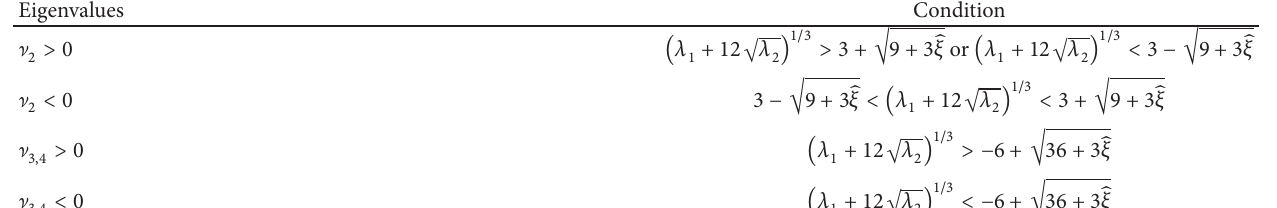
Table 3: Conditions for ] 2 , ] 3 , and ] 4 to be positive or negative. Here,